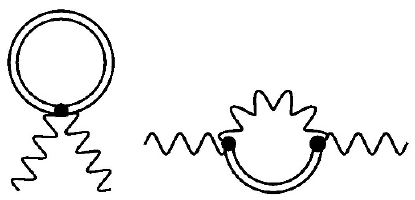
Figure 2 . Double lines denote metric (cid:13)uctuations and wavy lines gauge bosons. Two diagrams with quantum gravity contributions enter the expression for (cid:17) A